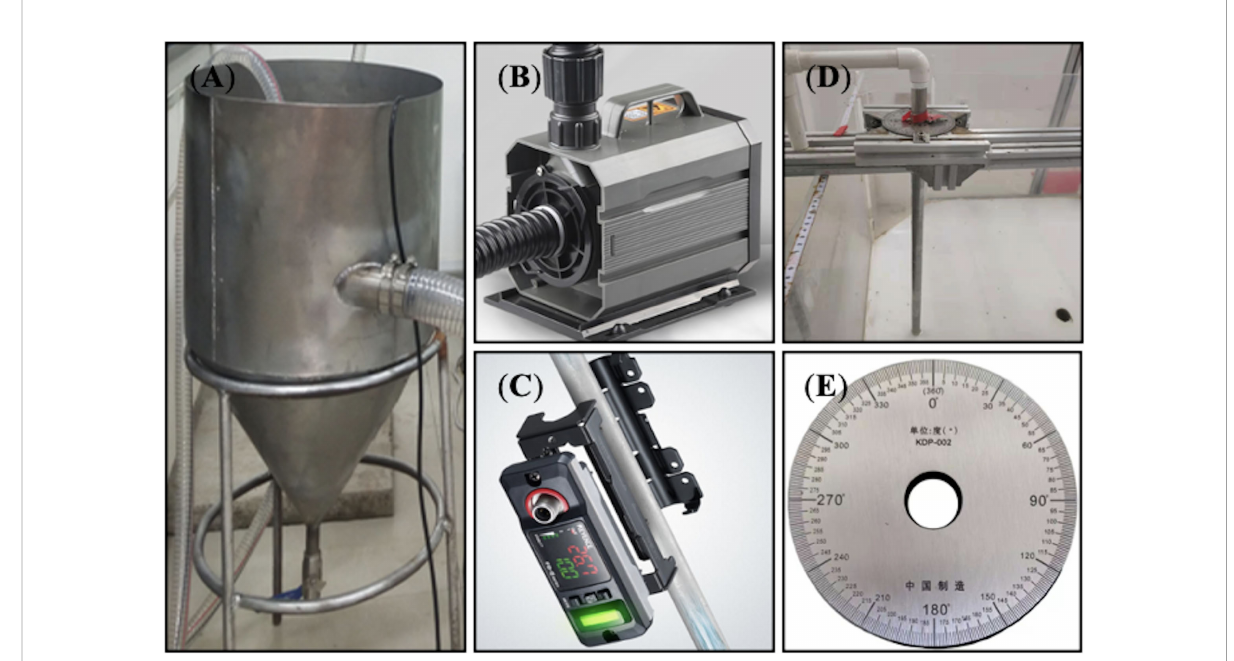
FIGURE 3 Main components of the experiment: (A) Reservoir; (B) Water pump; (C) Flowmeter; (D) Inlet assembly; (E)